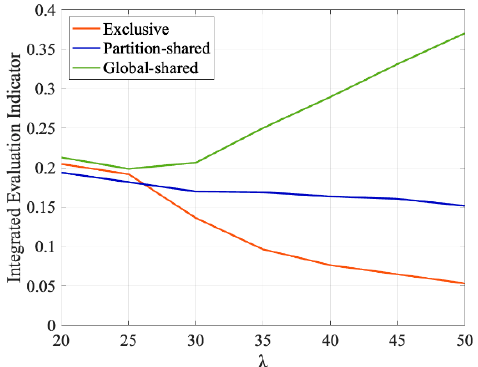
Figure 11. Comprehensive Evaluation Index under Different Procedures Based on Monte-Carlo Simulation.